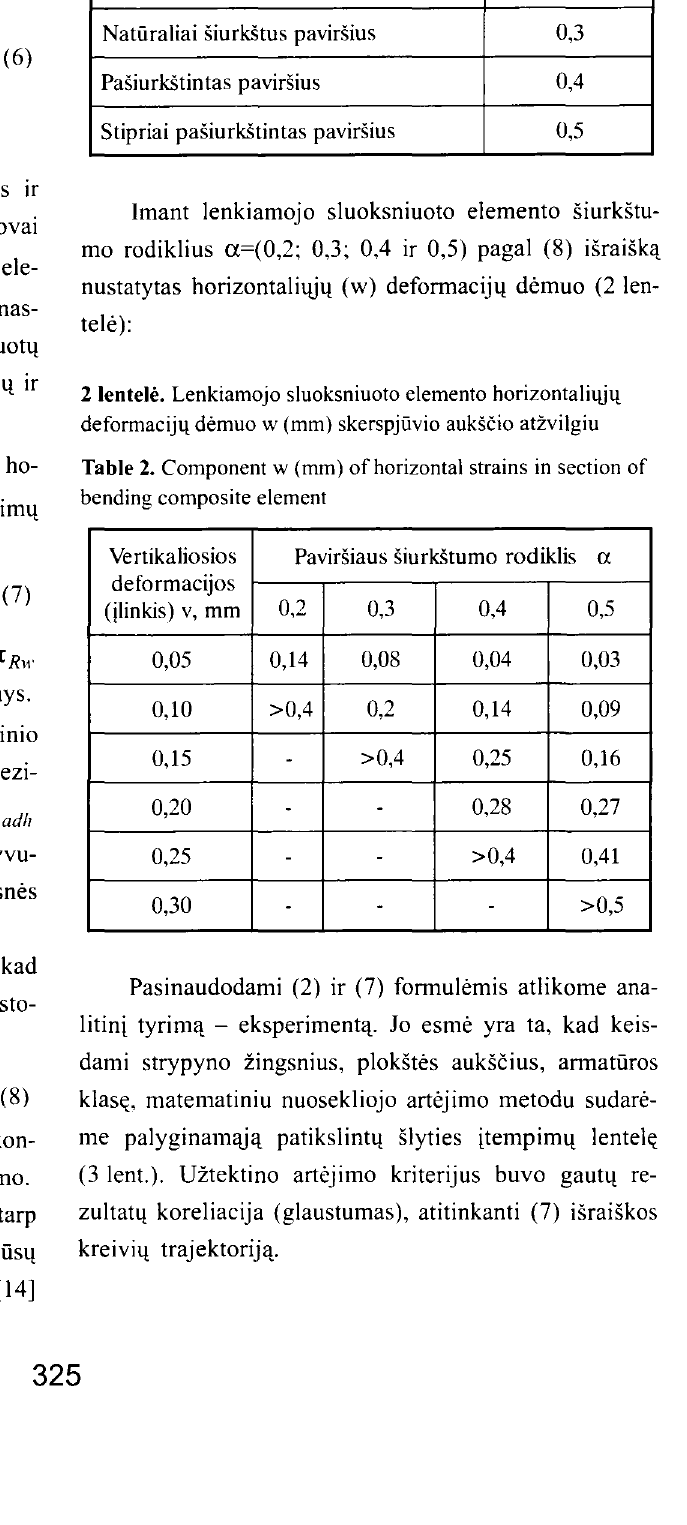
Table 1. The index a of concrete surface roughness